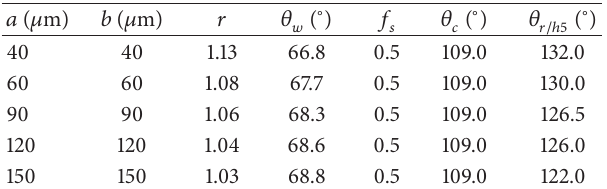
Table 1: The characteristics of prepared grooved surface: width 𝑎 , spacing 𝑏 , roughness factor 𝑟 , apparent CAs in the Wenzel model 𝑓 𝜃 𝑤 , fraction 𝑠 , apparent CAs in the Cassie-Baxter model measurement results of CAs 𝜃 𝑟/ℎ5 ( ℎ = 5 𝜇